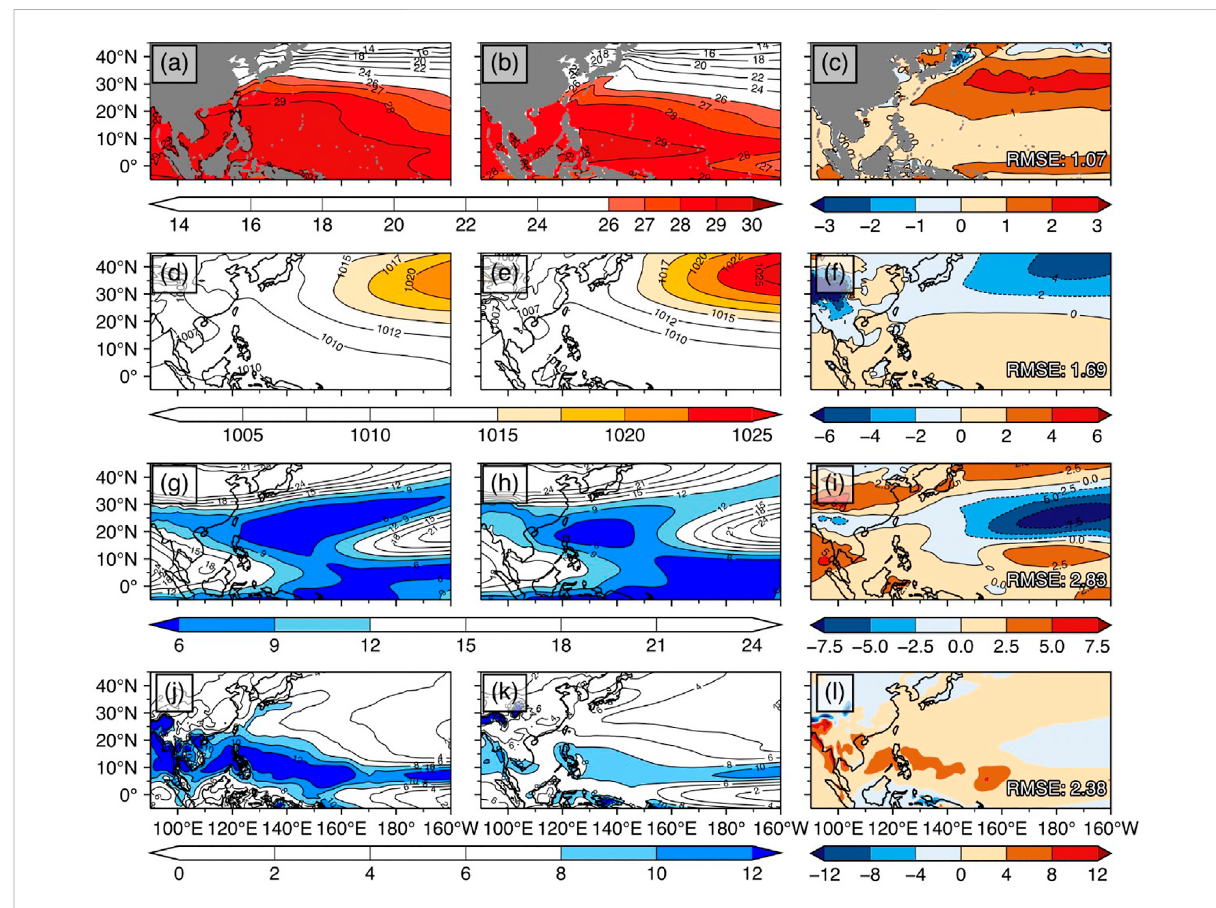
FIGURE 1 June-to-October mean sea surface temperature ( ° C) for the period of 1979 – 2005, derived from (A) JRA-55 and (B) CESM. (C) is the difference between (A) and (B) . (D – F) , (G – I) , (J – L) showmeansofthesameperiodbutforsealevelpressure(hPa),zonalwindshear(m/s),andtotalprecipitation rate (mm/day),